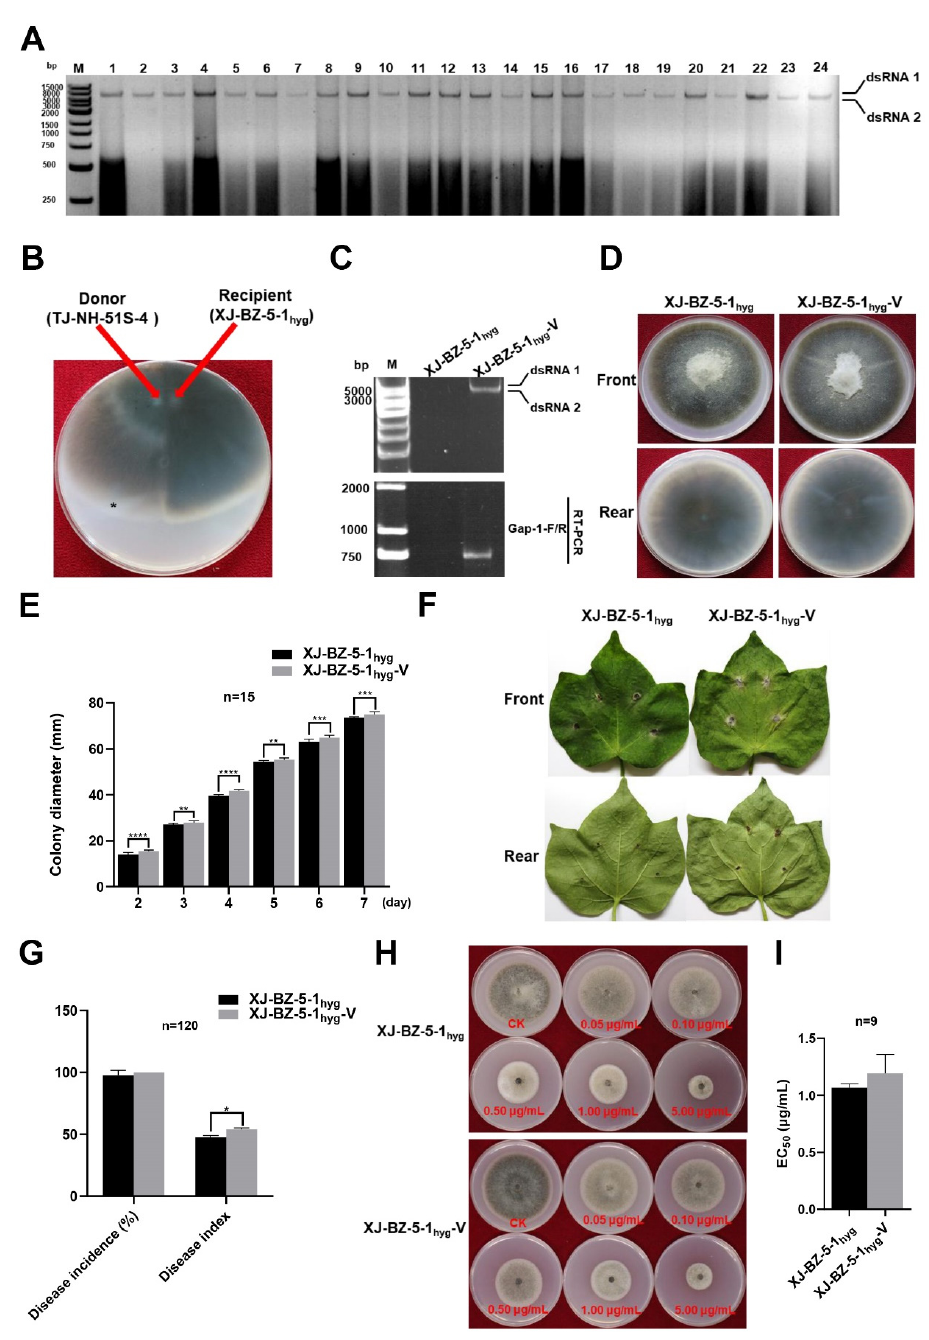
Figure 3. Vertical transmission via asexual spores and horizontal transmission through hyphal contact in pairing cultures of the mycovirus Alternaria alternata botybirnavirus 1-AT1 (AaBRV1-AT1). ( A ) Validation of positive presence of AaBRV1-AT1 in the 24 single-spore cultures derived from strain TJ-NH-51S-4 by dsRNA profiles using agarose gel electrophoresis (M: 250 bp DNA Ladder). ( B ) Pairing cultures of colonies of Alternaria tenuissima strain TJ-NH-51S-4 (donor strain, on the left) and A. tenuissima strain XJ-BZ-5-1 hyg (recipient strain, on the right) on the same PDA plate. The symbol ‘*’ over the colony indicates the location where a mycelial agar plug was collected and transferred to fresh PDA plates to obtain strain XJ-BZ-5-1 hyg -V carrying AaBRV1-AT1 (AaBRV1-AT1 was horizontally transmitted from strain TJ-NH-51S-4 to strain XJ-BZ-5-1 hyg to obtain XJ-BZ-5-1 hyg -V). ( C ) Confirmation of AaBRV1-AT1 in strains XJ-BZ-5-1 hyg and XJ-BZ-5-1 hyg -V by dsRNA profiles (top) extracted from the two strains and separated using agarose gel electrophoresis (M: DNA